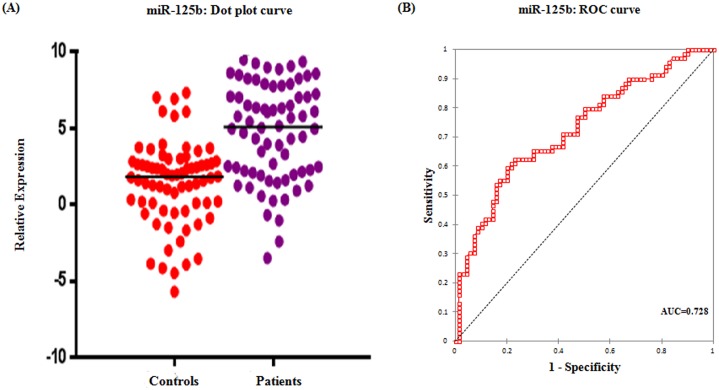
Serum expression of miR-125b.(A) Dot plot showing the relative expression of miR-125b in patients and controls (B) ROC curve for miR-125b exhibiting its diagnostic potential in epithelial ovarian cancer.